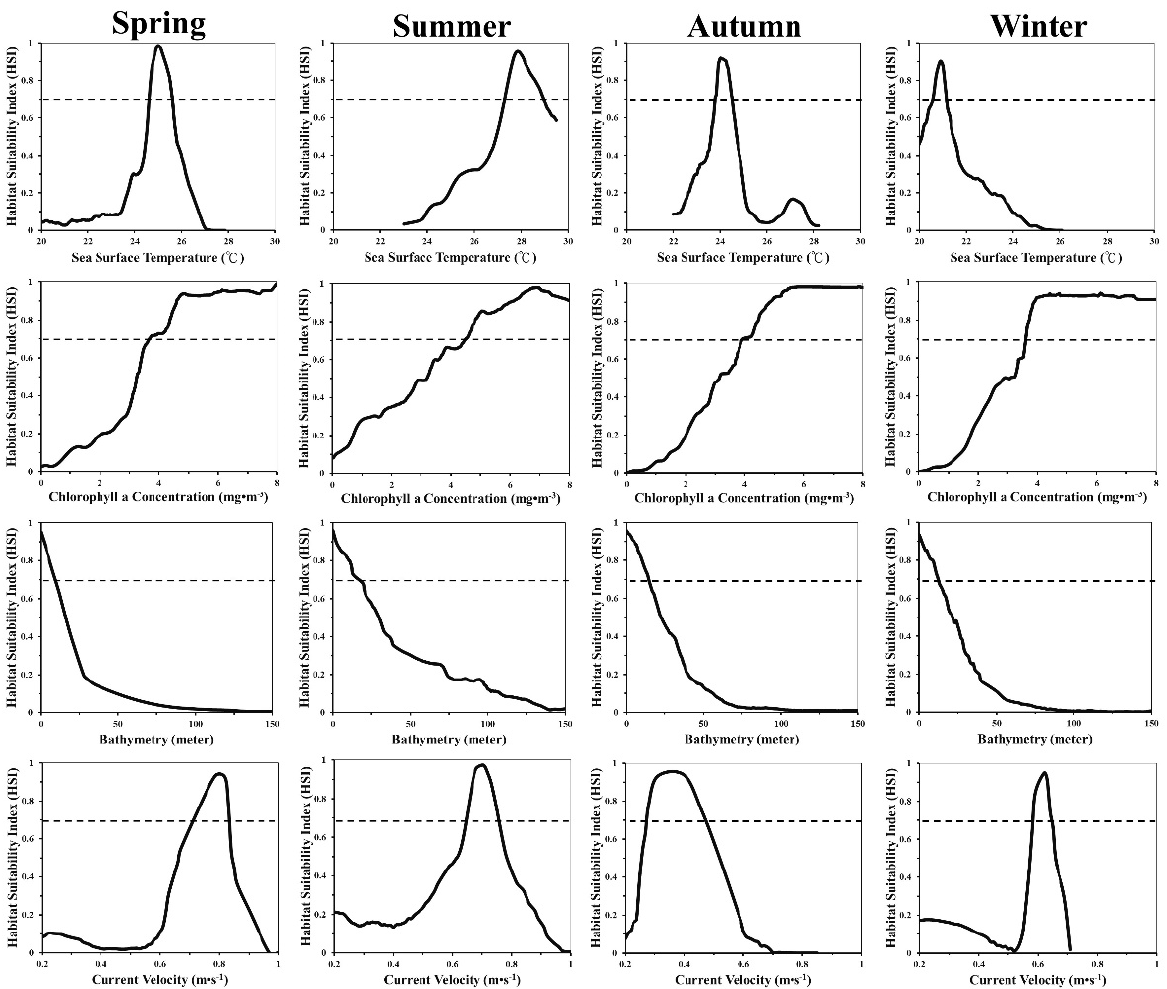
Figure 5. Response curves of environmental variables derived from the MaxEnt model by season. Horizontal lines indicate suitable environmental variable ranges for black sea bream in waters off western